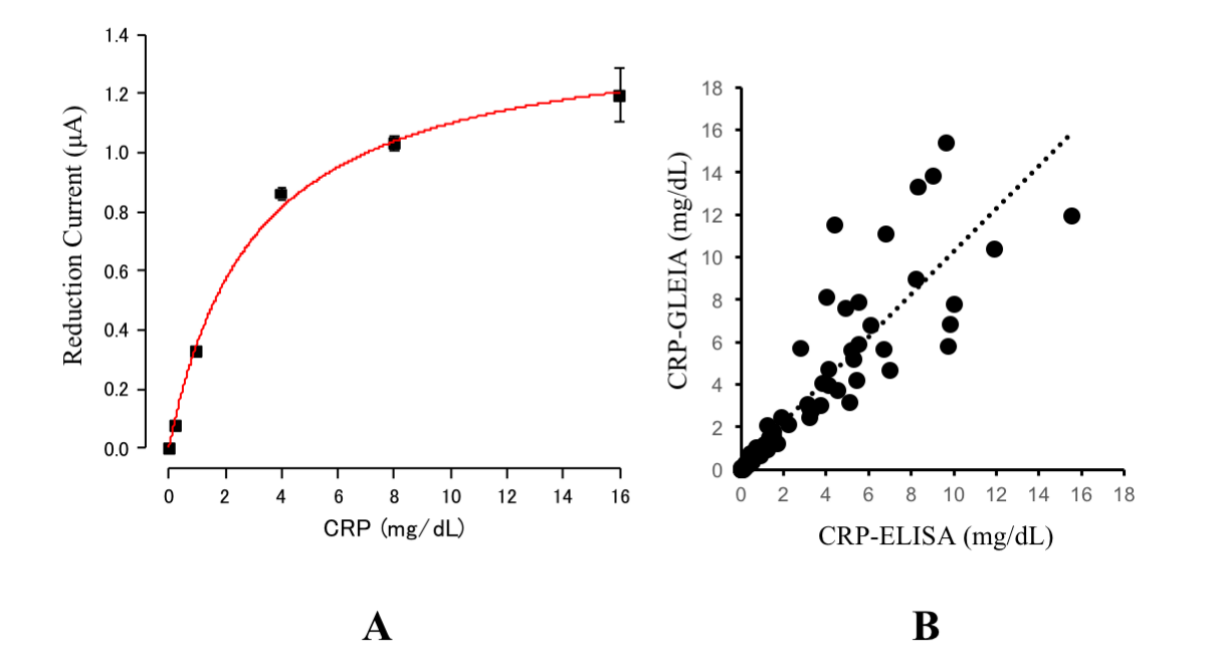
Figure 3. The current-to-CRP calibration curve (A) and the correlation between the chips-measured CRP levels and the laboratory-measured CRP levels (B). CRP: c-reactive protein; ELISA: enzyme-linked immunosorbent